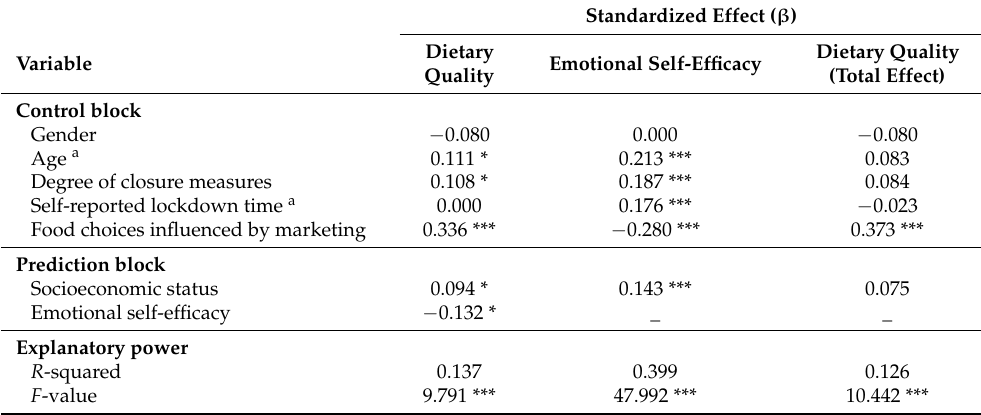
Table 4. Multiple regression analysis for disparities in dietary quality, behavior, self-efficacy, and socioeconomic